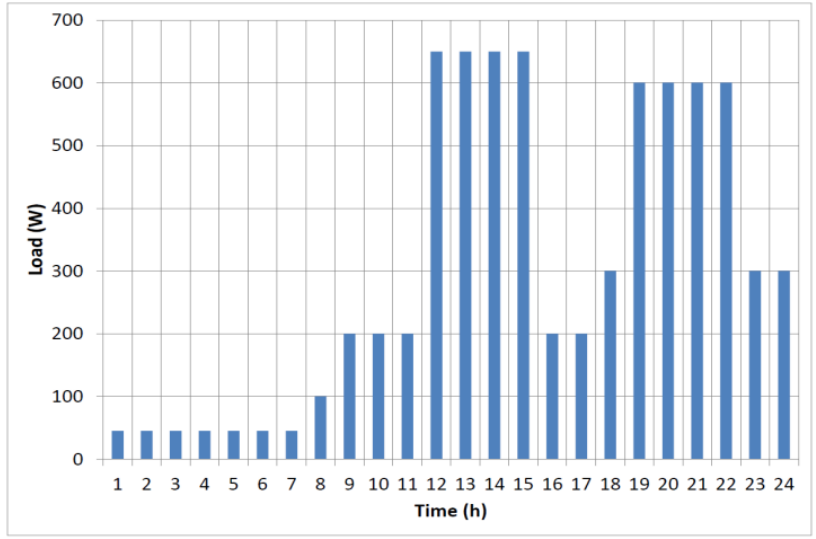
Figure 4. Hourly electricity load distribution with 450 W additional load.